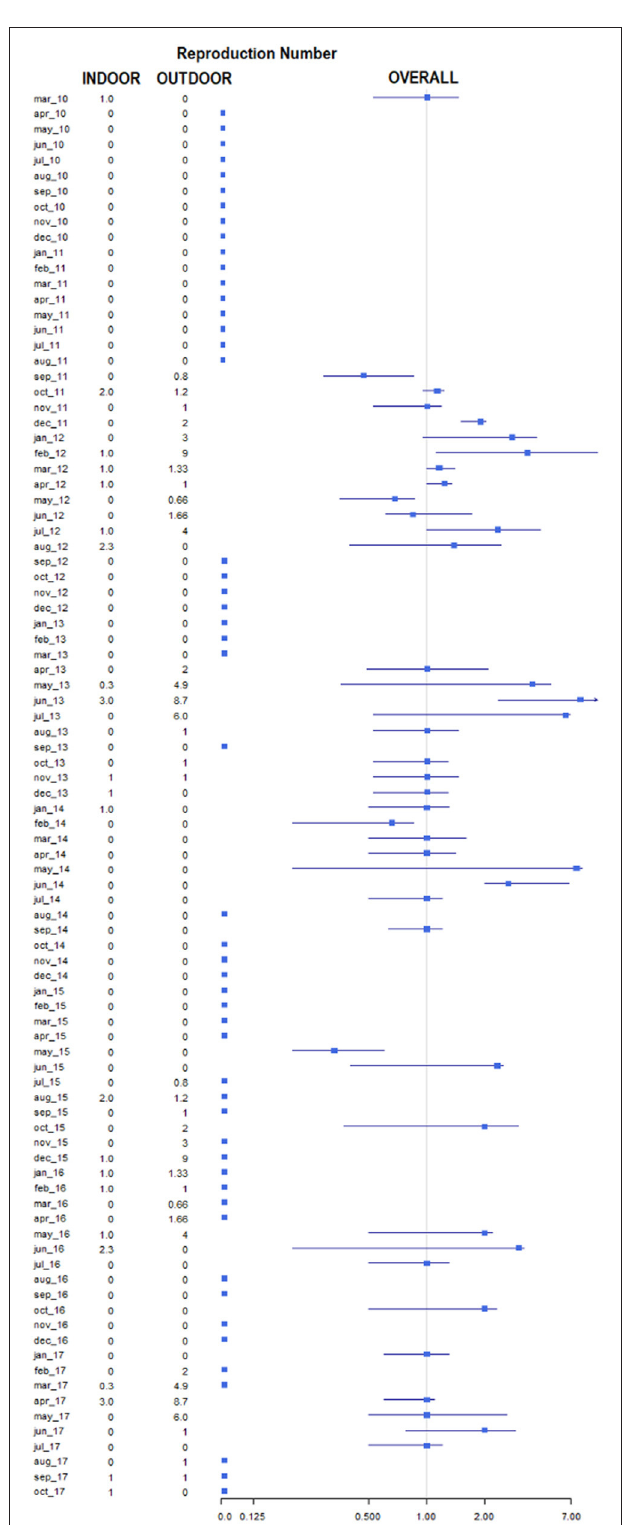
FIGURE 6 | Forestplot representing the average number of secondary cases (reproduction number) by month and year. Data are reported as overall (squares represent the estimates, lines indicate the 95% confidence intervals), average number in indoor and